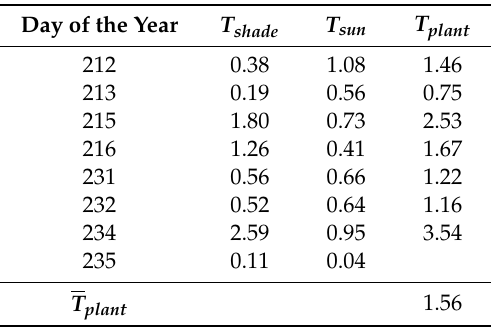
Table 3. Modified Penman–Monteith T plant estimates during the same days that sap flow was measured at the Coniferous site. T plant is the summation of T shade and T sun . T plant is the average of the daily T plant . All estimates are in mm / d.